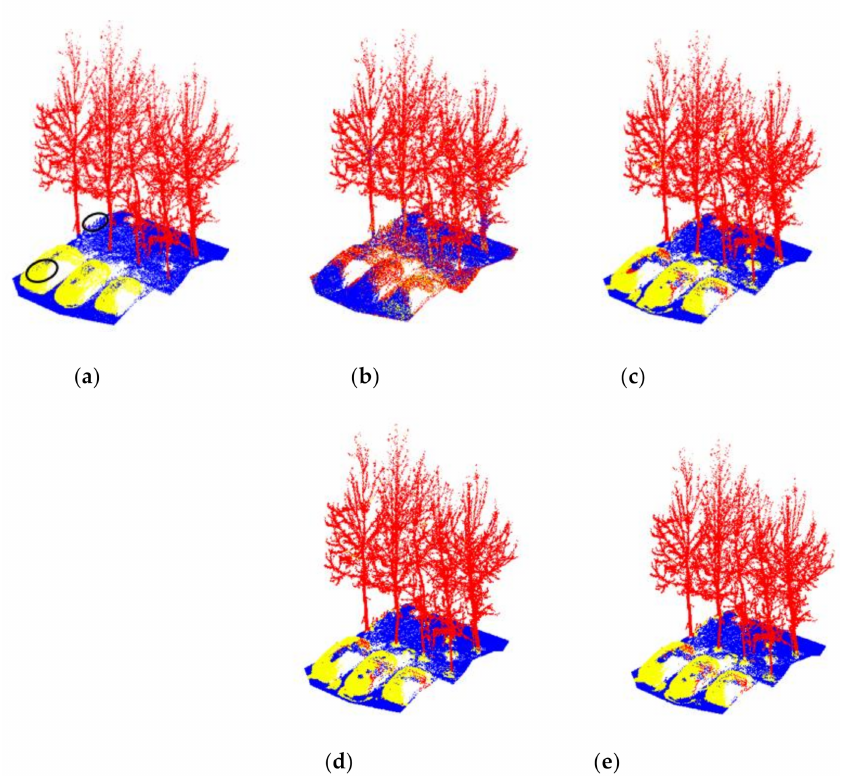
Figure 9. Classification results for Scene 1. ( a ) Ground truth; ( b ) Method 1; ( c ) Method 2; ( d ) Method 3; and ( e ) our method. Red, blue, and yellow points represent trees, floors, and cars,